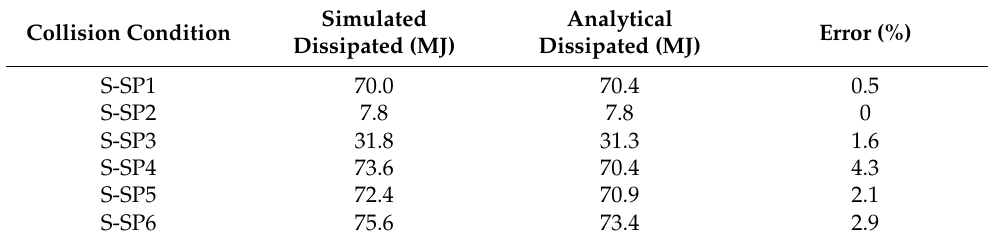
Table 9. The dissipated energy comparison between the simulation results and theoretical analysis results.